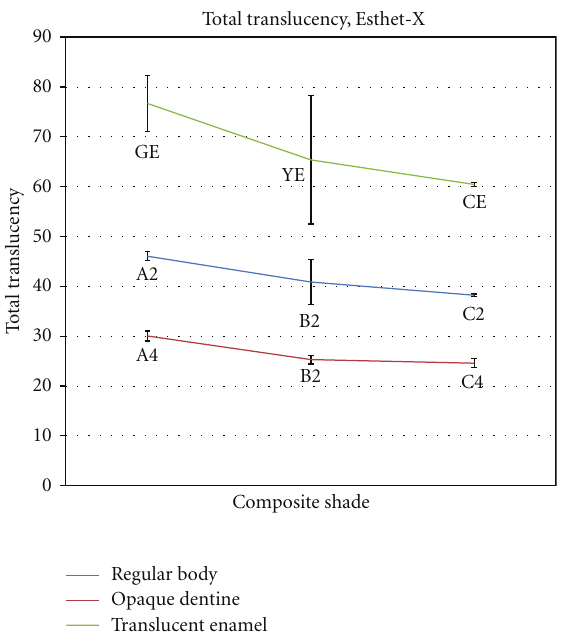
Figure 3: Mean di ff use translucency of di ff erent shades of Esthet-X composite resin.